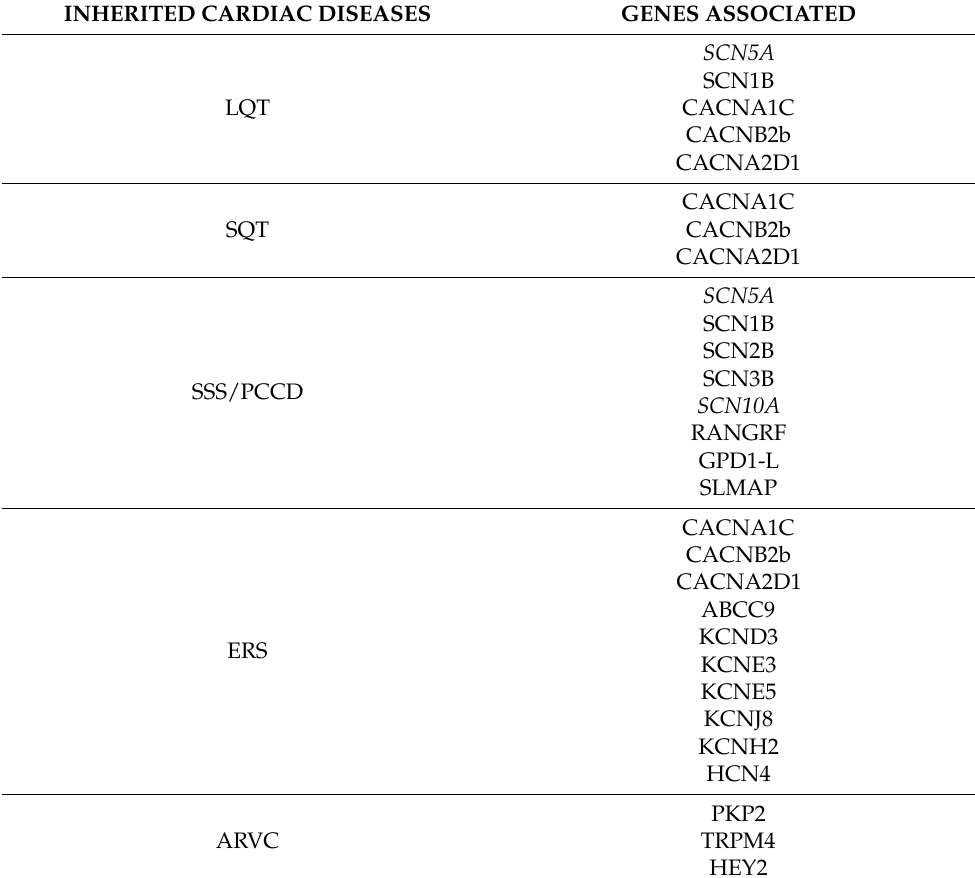
Table 1. Genes associated with Brugada syndrome (BrS) and other inherited arrhythmia diseases